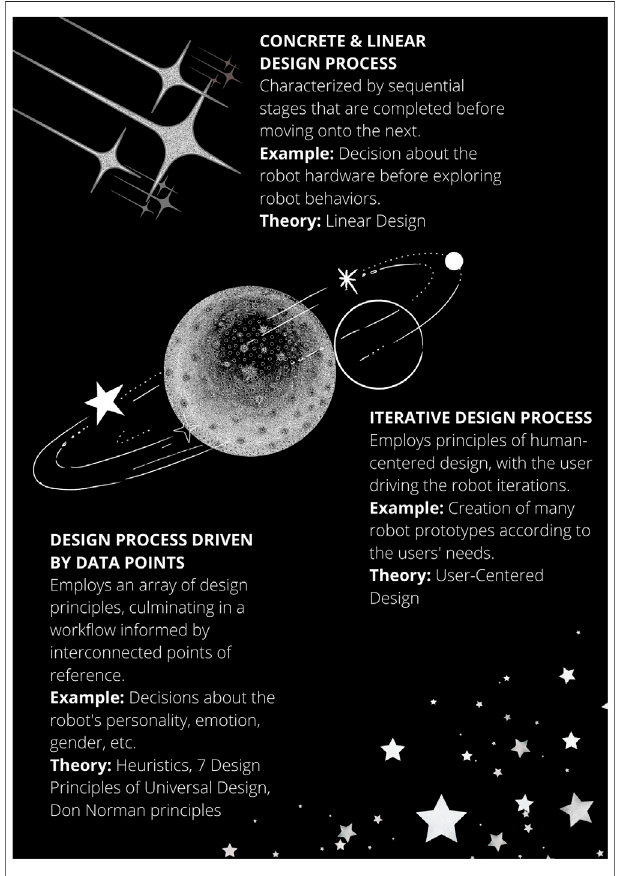
FIGURE 2 | Design process of social